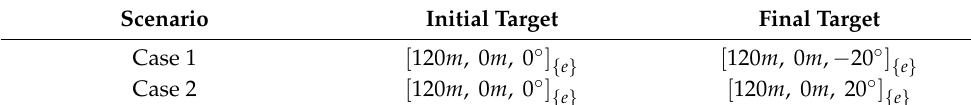
Table 5. Scenarios for dynamic positioning control of a FPSO.